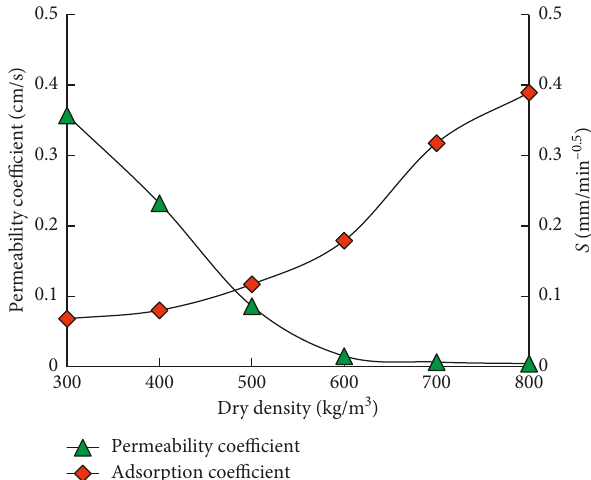
Figure 4: Relationship between permeability coefficient and adsorption coefficient with dry density.